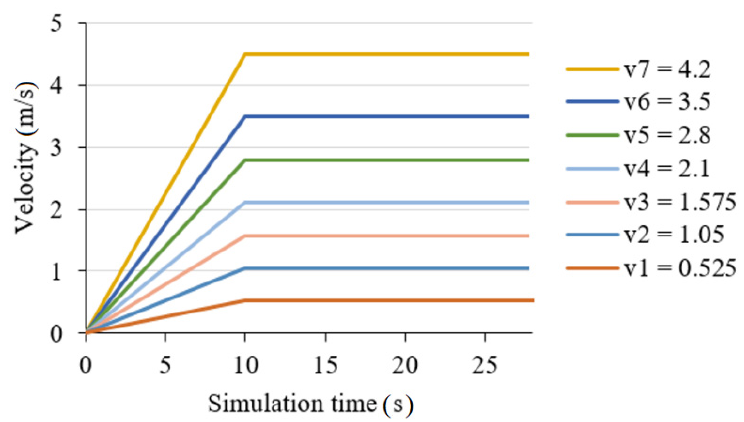
Figure 6. Assumed velocity profiles.